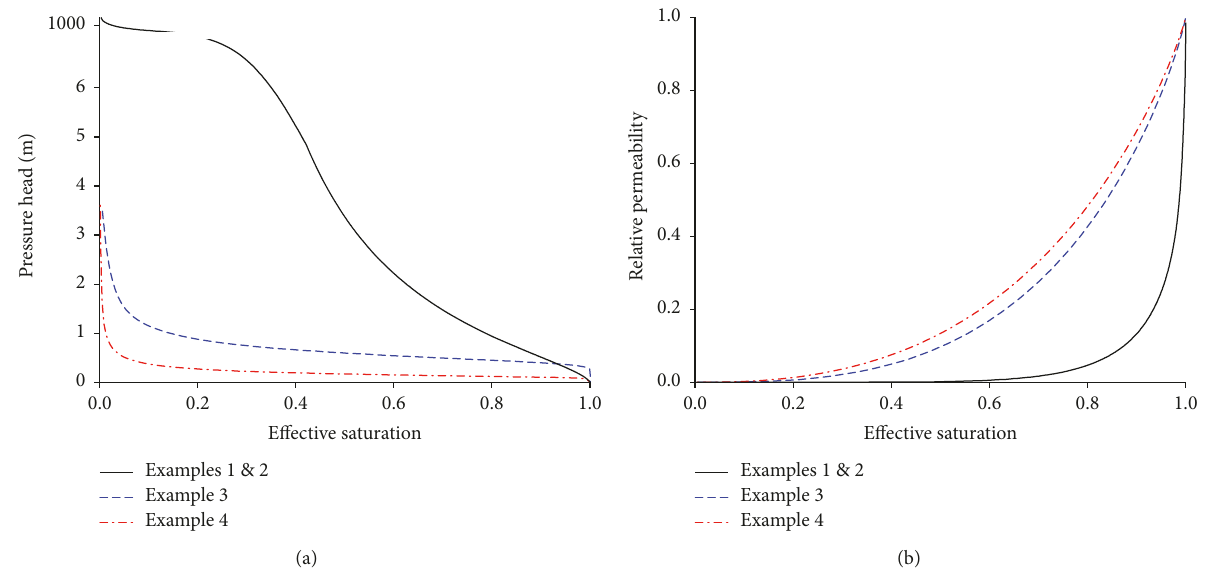
Figure 4: Constitutive relationships for four examples in Section 5: (a) pressure head versus saturation relationships and (b) relative permeability versus saturation relationships.